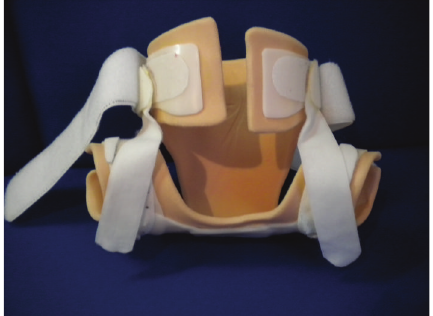
Figure 1: Brace, view from